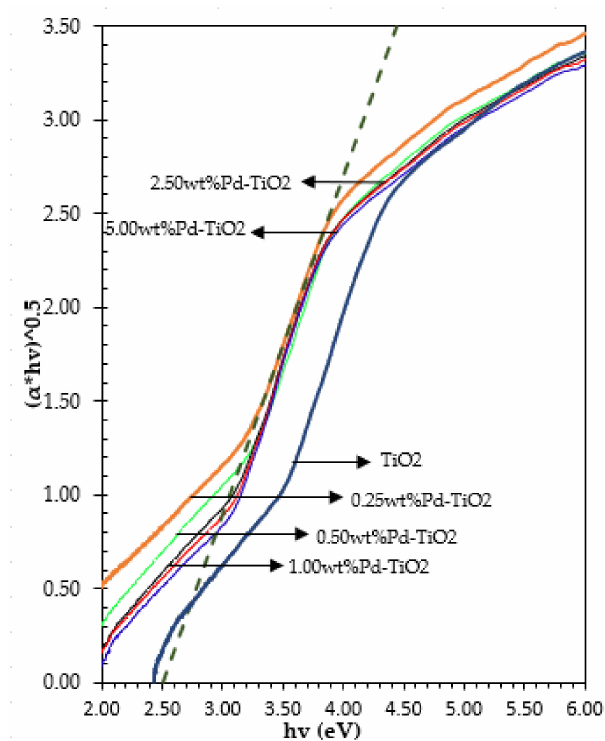
Figure 4. Band Gap Calculation Using the Tauc Plot Methodology. A straight-line extrapolation is shown for the 0.25 wt% Pd–TiO 2.